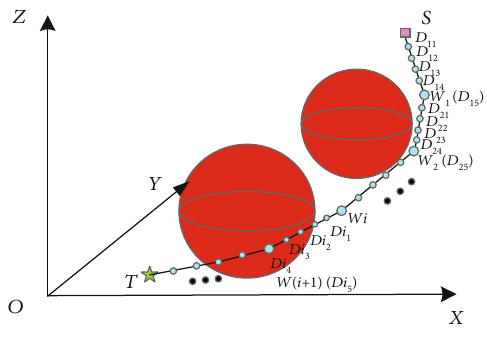
Figure 2: The fl ight trajectory in 3D